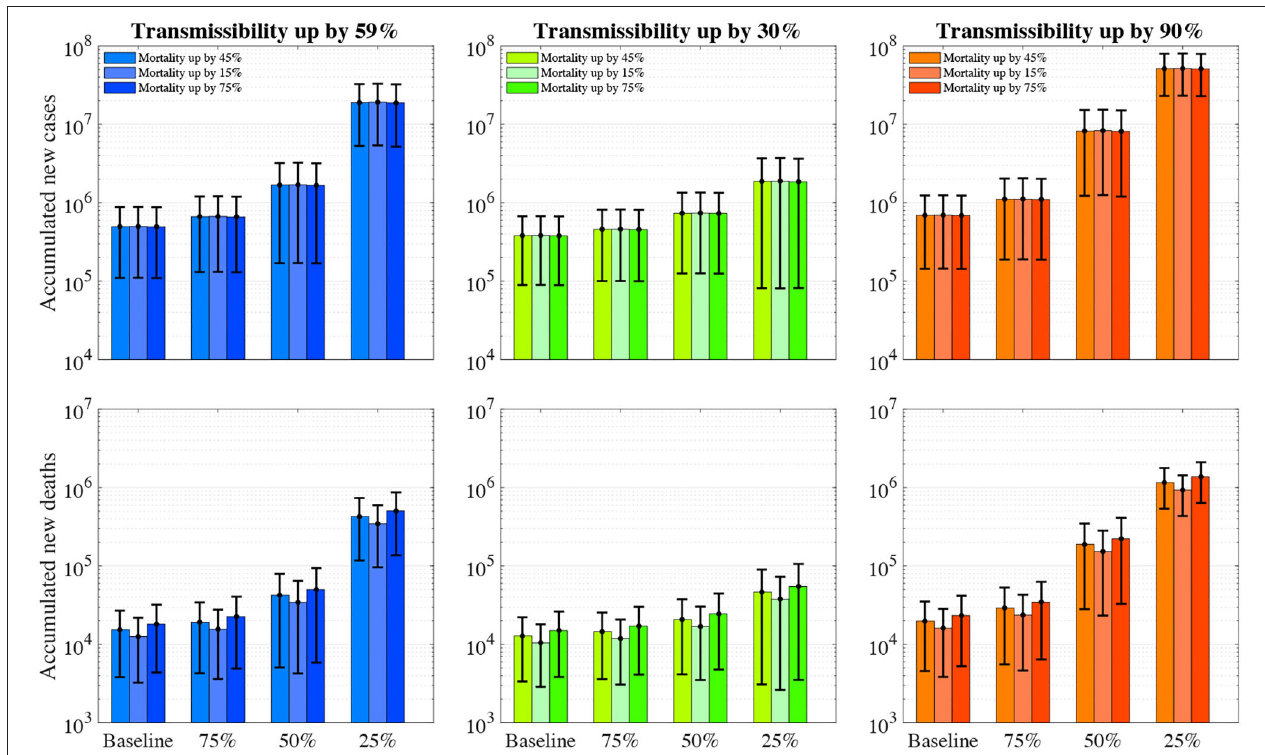
FIGURE 2 | The number of accumulated new COVID-19 infections and deaths over the next 12 months with varying vaccine effectiveness, viral transmissibility and mortality. The first row represents the accumulated number of new infections whereas the second row represents accumulated deaths. The colour (blue, green, and orange) bars denote the varying transmissibility of SARS-CoV-2 variants. The error bars represent 95% confidence intervals.